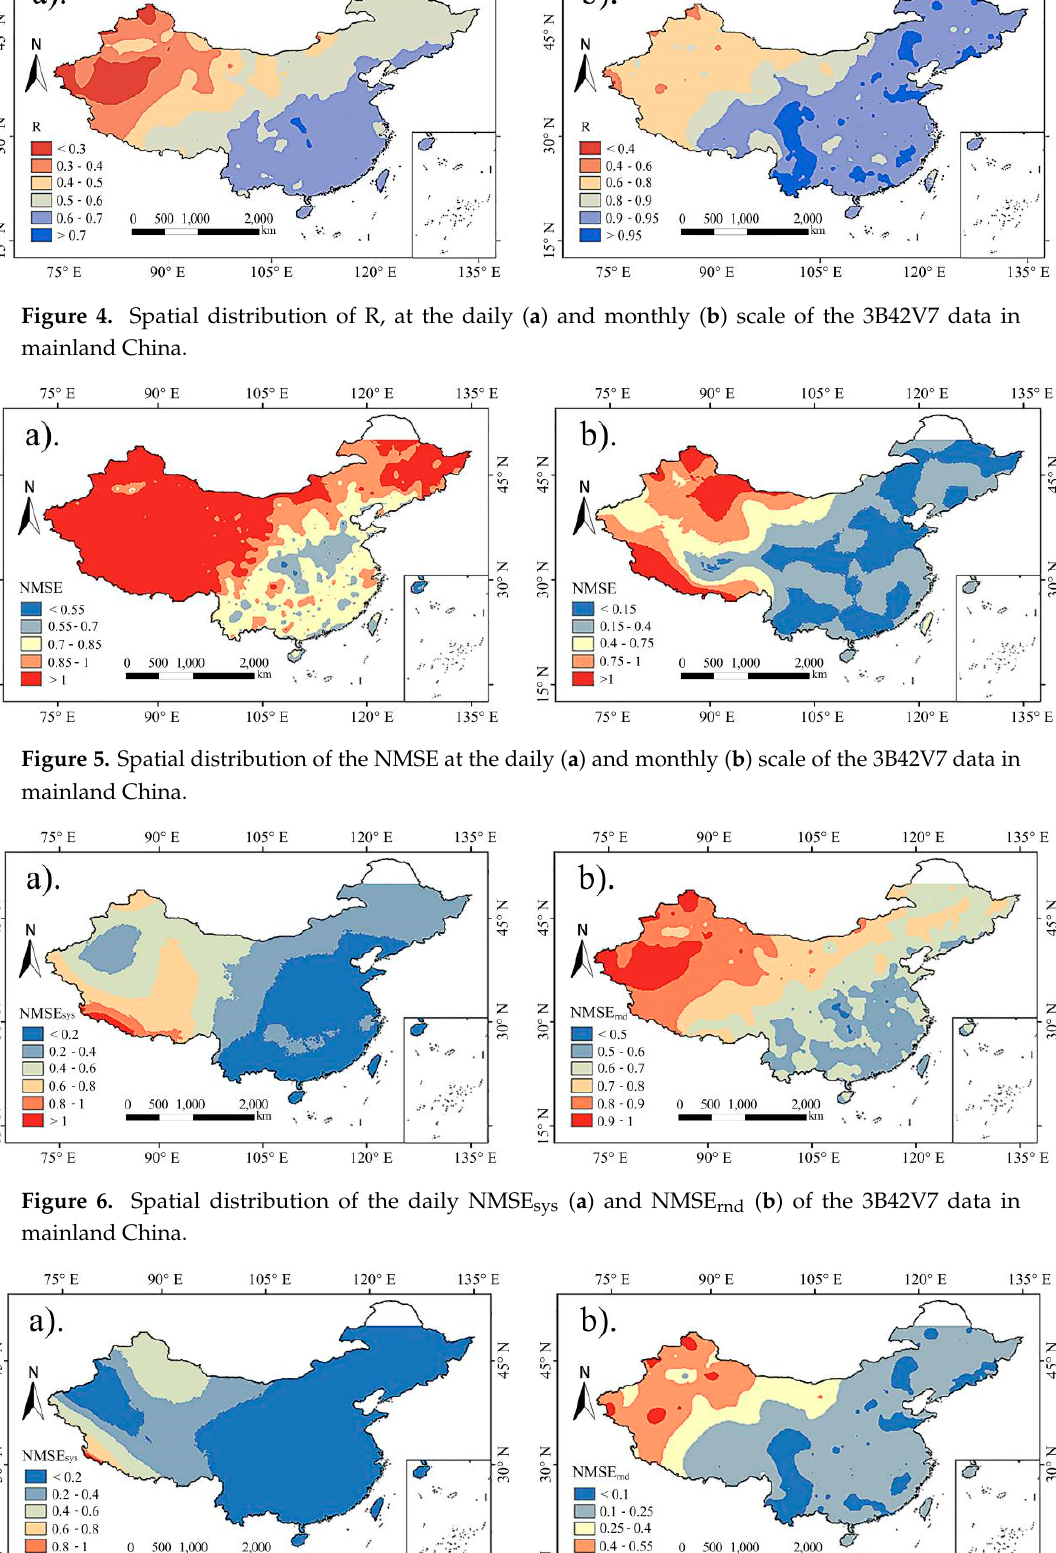
Figure 4. Spatial distribution of R, at the daily ( a ) and monthly ( b ) scale of the 3B42V7 data in mainland China.